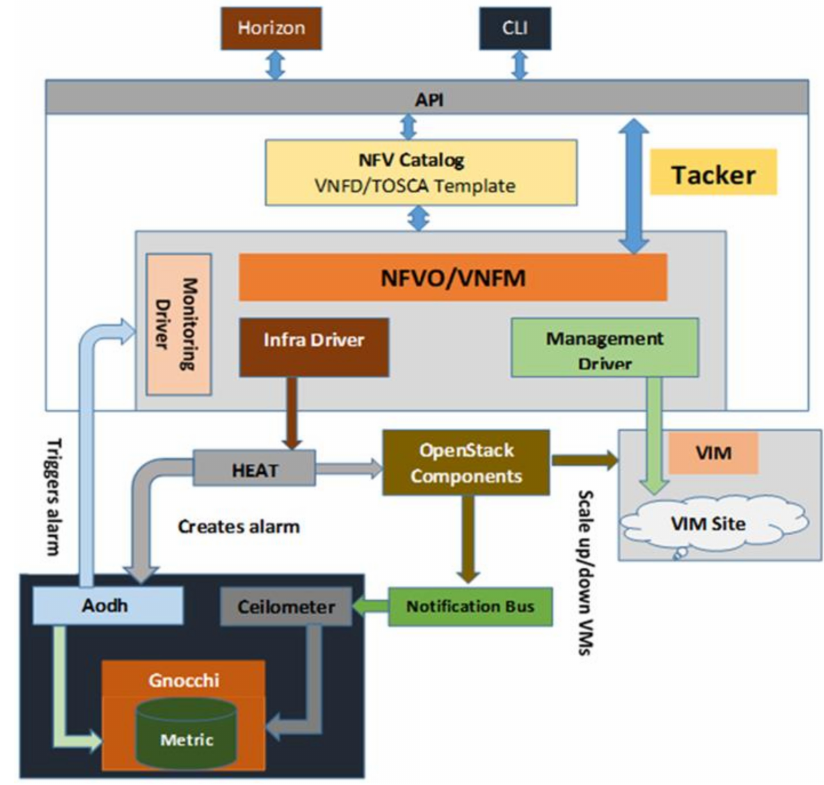
Figure 3. Proposed framework for auto-scaling of